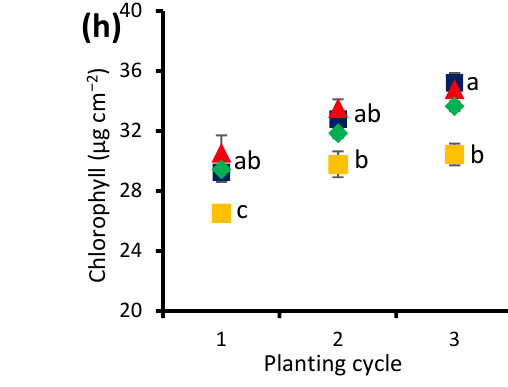
Figure 1. Means (±SE) of interaction between treatments and planting cycle for: ( a ) plant height, ( b ) number of leaves, ( c ) shoot fresh weight, ( d ) shoot dry weight, ( e ) leaf fresh weight, ( f ) leaf dry weight, ( g ) total leaf area, and ( h ) leaf chlorophyll content. On the same chart, means with the same letters are not significantly different ( p > 0.05) from one another using Tukey’s test. All measurements are expressed on a per plant basis.